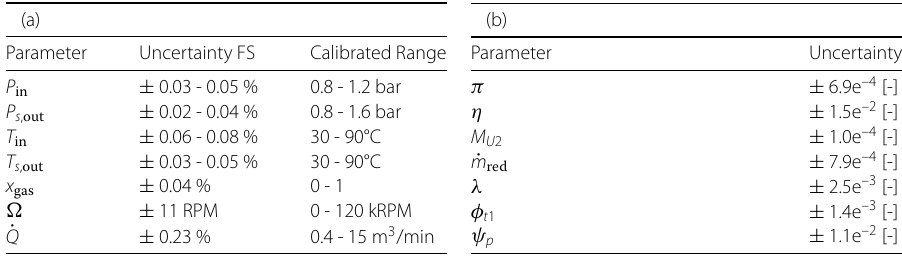
Table 1 Summary of the uncertainty analysis on (a) measured parameters and (b) calculated compressor performance